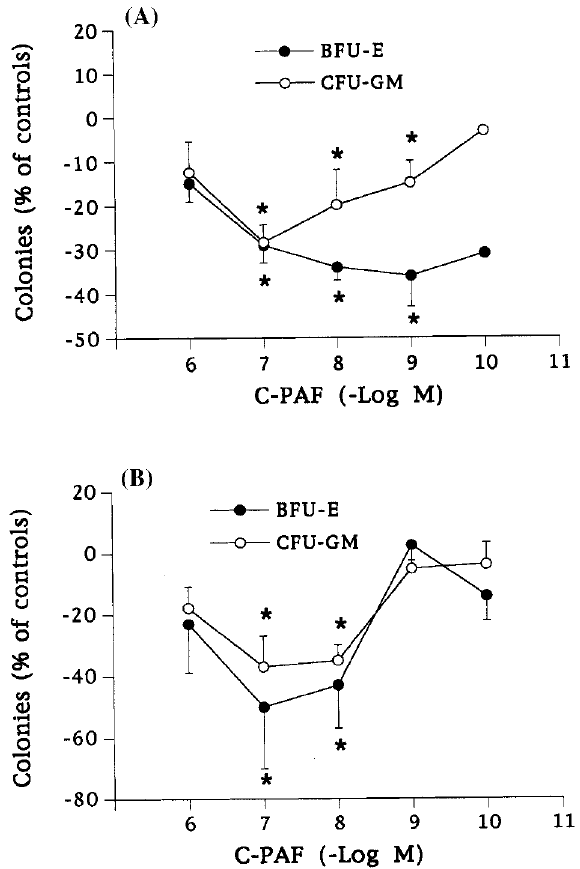
FIG. 2. Effect of C-PAF on the growth of BFU-E and CFU-GM colonies from marrow (A) and blood (B) CD34 + cells cultured 3 days in liquid medium before colony assay. (A) Percentage of variation of colony numbers compared with control values (three independent experiments). * P < 0.01 (Wilcoxon’s test). Colony numbers in controls were 28 ± 4 and 51 ± 3 for BFU-E and CFU-GM, respectively. (B) Percentage of variation of colony number compared with control values (three inde- pendent experiments). * P < 0.01 (Wilcoxon’s test). Colony number in controls were 16 ± 2 and 37 ± 3 for BFU-E and CFU-GM,